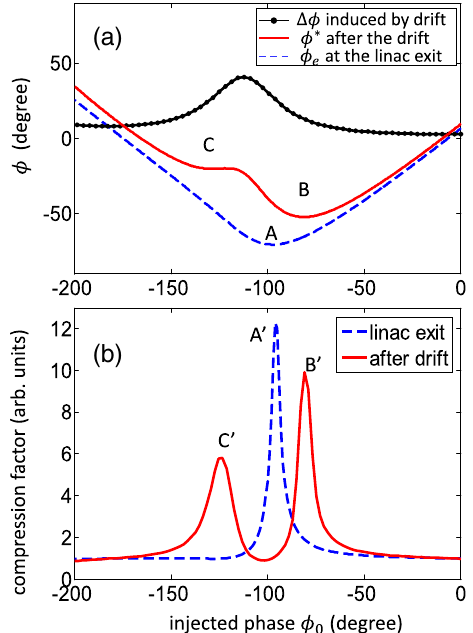
FIG. 2. Curves obtained by solving Eqs. (1) – (4) with the beam line parameters in Table I: (a) electron-phase-related quantities ϕ Δ ϕ , and ϕ (cid:3) versus the injected phase ϕ e , 0 and (b) compression factor of the electron beam versus the injected phase ϕ 0 ; the rms ¼ 1 bunch length of the beam is σ ϕ 0